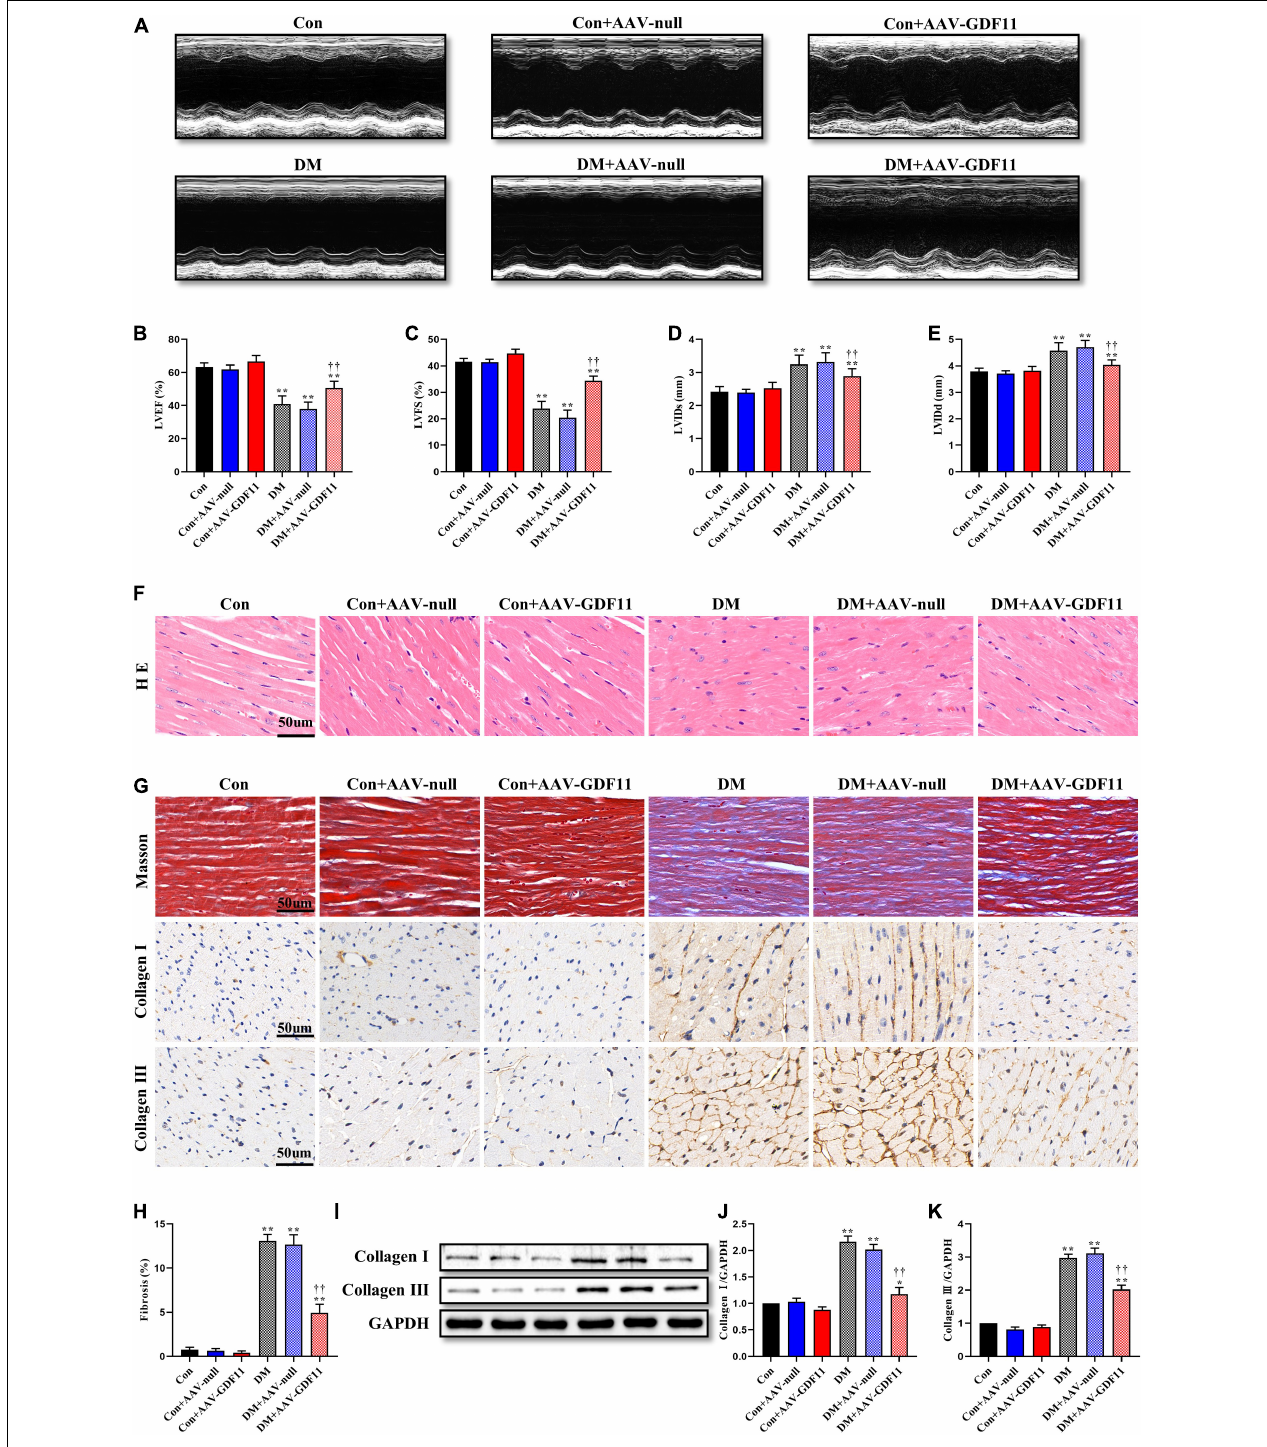
FIGURE 1 | Myocardial GDF11 overexpression improved cardiac systolic function and attenuates interstitial fibrosis. (A) Representative images of M-mode echocardiography. (B) Left ventricular ejection fraction (LVEF). (C) Left ventricular fractional shortening (LVFS). (D) Left ventricle internal dimension in systole (LVIDs). (E) Left ventricle internal dimension in diastole (LVIDd). (F) Representative images of myocardial sections stained with hematoxylin and eosin (H&E) (scale bar = 50 µ m). (G) Representative images of Masson’s trichrome staining and immunohistochemistry for Collagen I and Collagen III (scale bar = 50 µ m). (H) Interstitial fibrosis in myocardial sections. (I) Representative blots of Collagen I and Collagen III. (J) Quantitative expression of Collagen I. (K) Quantitative expression of Collagen III. Data are presented as the mean ± SEM, n = 5 or 6 per group. *,** P < 0.05, 0.01 versus the Con group, †† P < 0.01 versus the DM group.